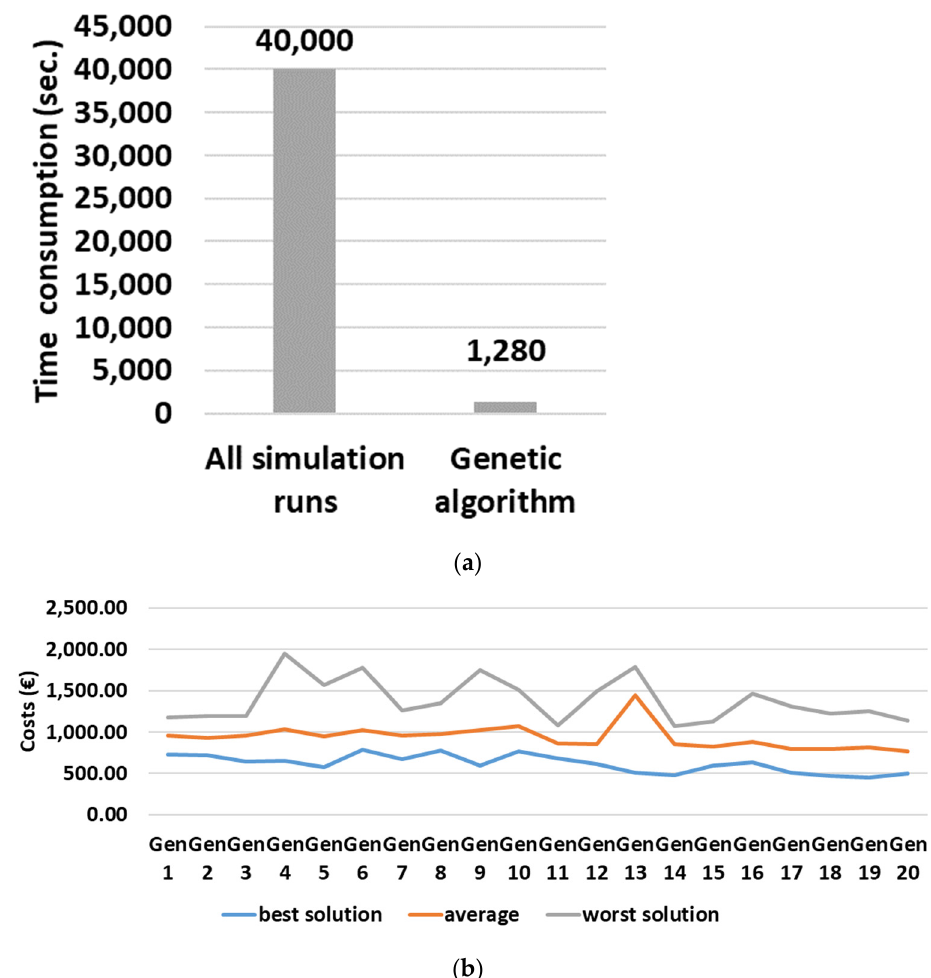
Figure 12. ( a ) A time-consuming simulation run without genetic algorithms and a simulation run with genetic algorithms; ( b ) the cost of the best, average, and worst solutions for generations. After implementing the experiments, a table of the best solutions was generated, with the corresponding values of fitness shown in Table 2. Table 2. Best result in optimisation using genetic algorithms for three observations. Fitness End of the Simulation